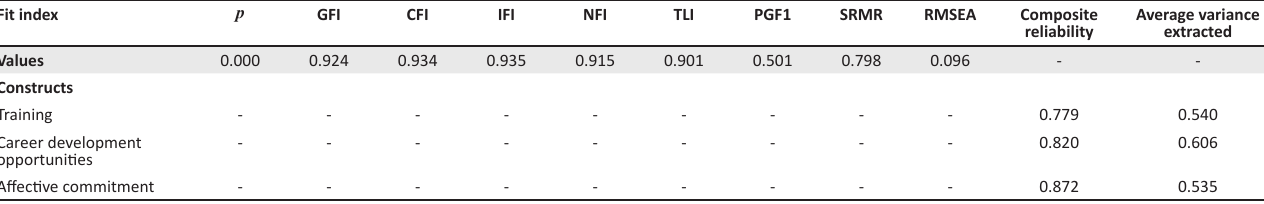
TABLE 2 : Measurement model fit and composite